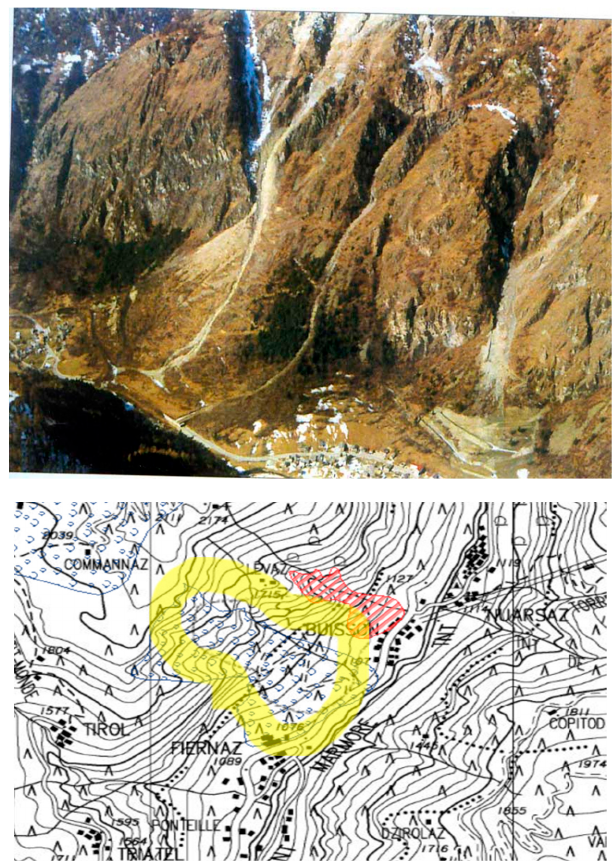
Figure 6. The Fiernaz slope: in yellow, its perimeter as identified by students.